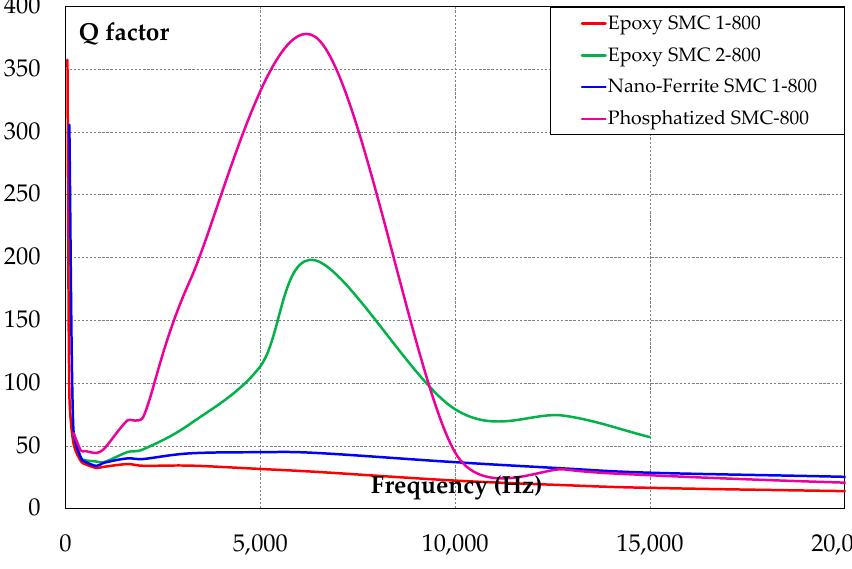
Figure 11. The Q factor of the toroid samples of the proposed SMC materials .